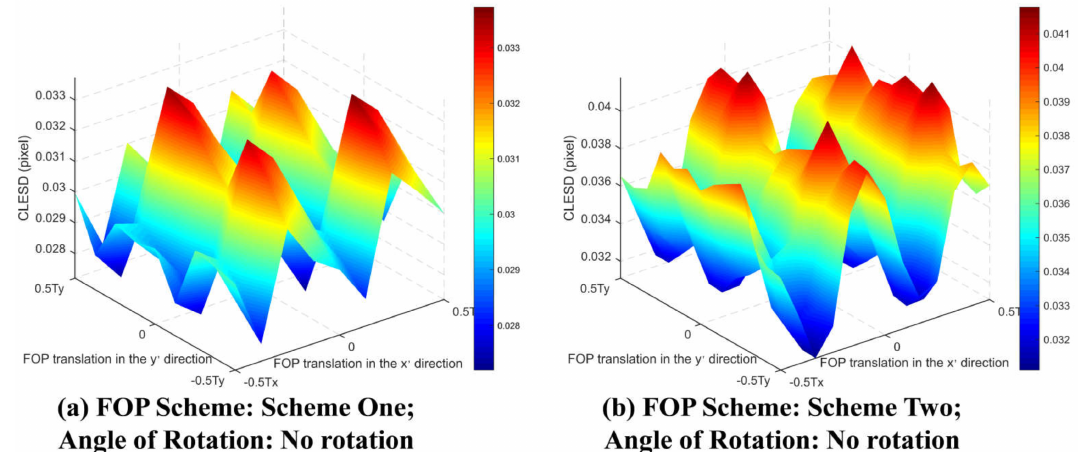
√ (cid:16) (cid:17) T y = 2 3 R . The connection between the FOP